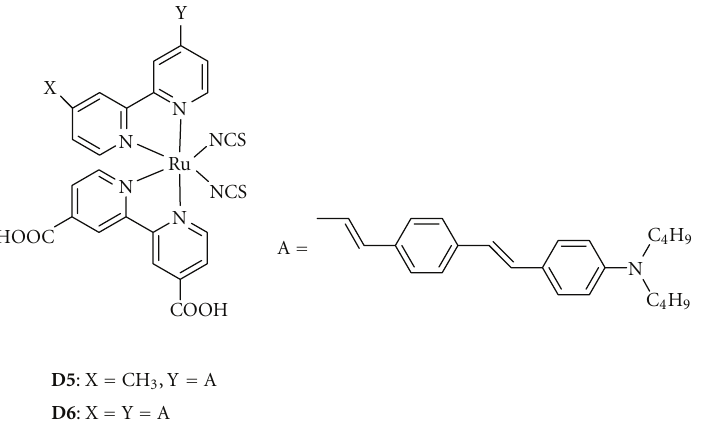
Figure 13: Molecular structures of D5 and D6 (taken from [30]).